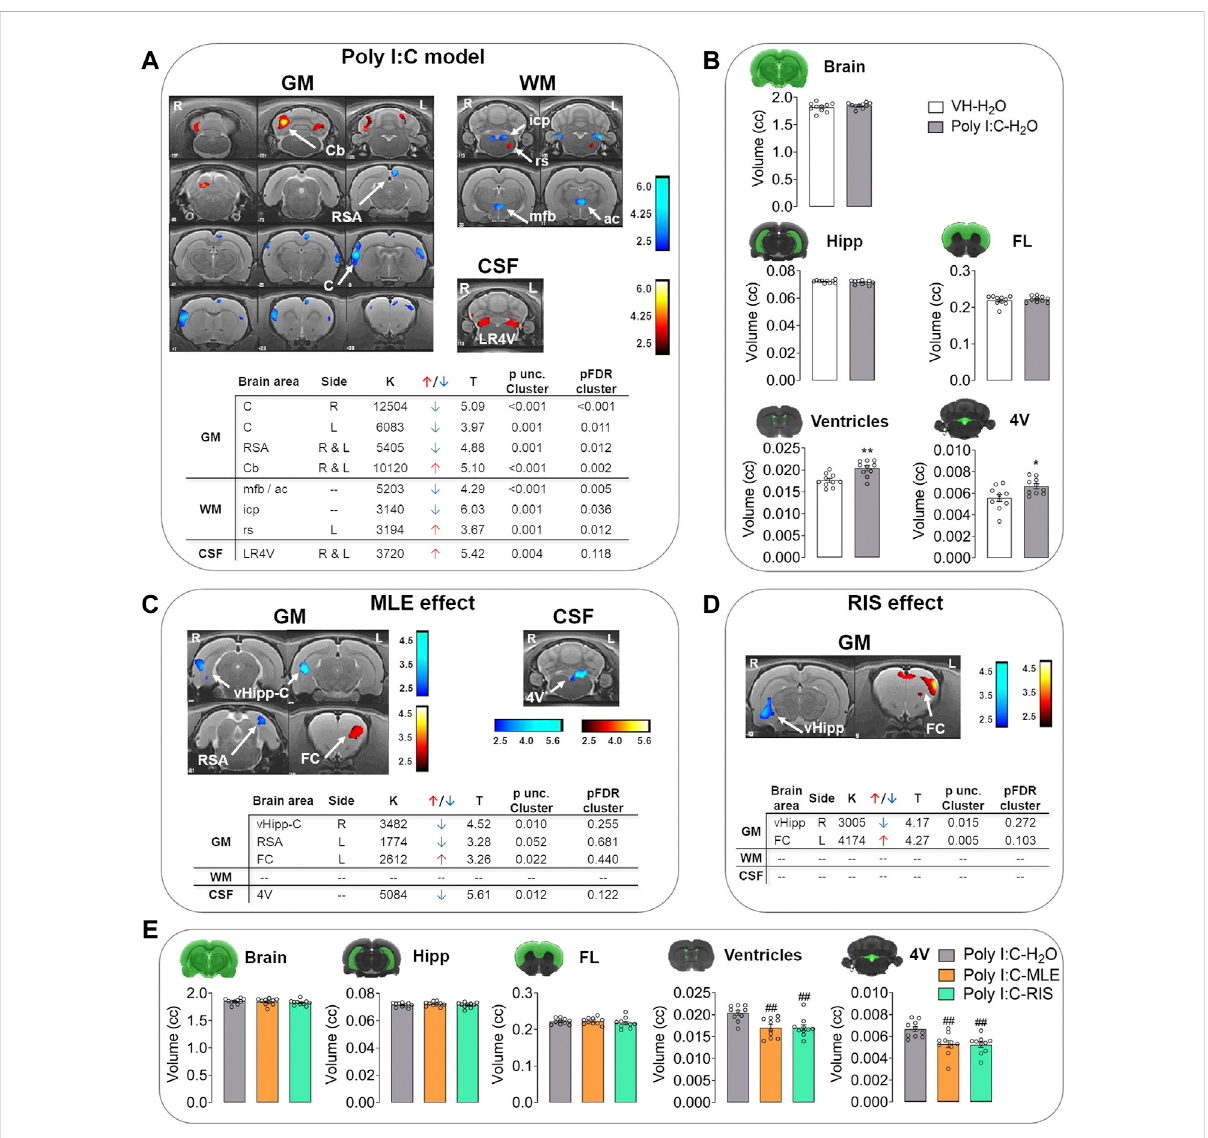
FIGURE 3 The effect of MLE or risperidone (RIS) treatment during adolescence on brain volumetric changes measured by MRI. (A) Voxel-based morphometry(VBM) and (B) regionsofinterest (ROI)analysisinthePoly I:Cmodel(phenotype).VBM resultsare representedinT-mapsoverlaid